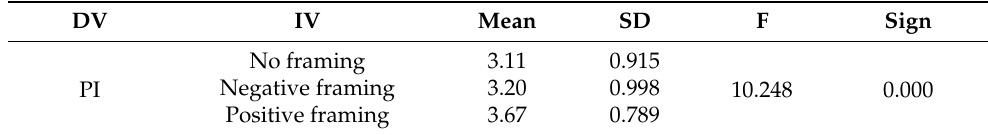
Table 4. Results of one-way ANOVA.